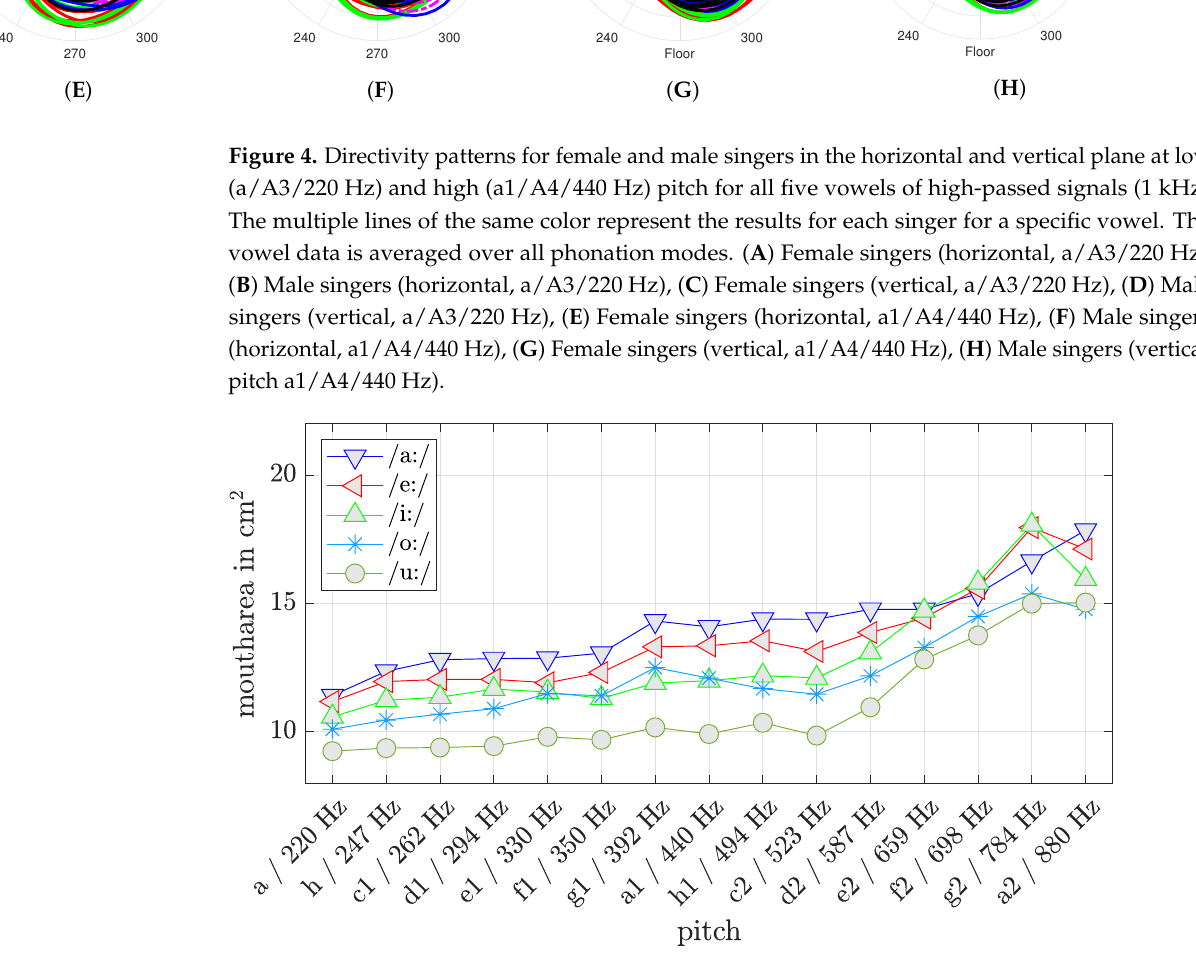
Figure 5. Mean effective mouth opening calculated from tracking data for the five vowels from six